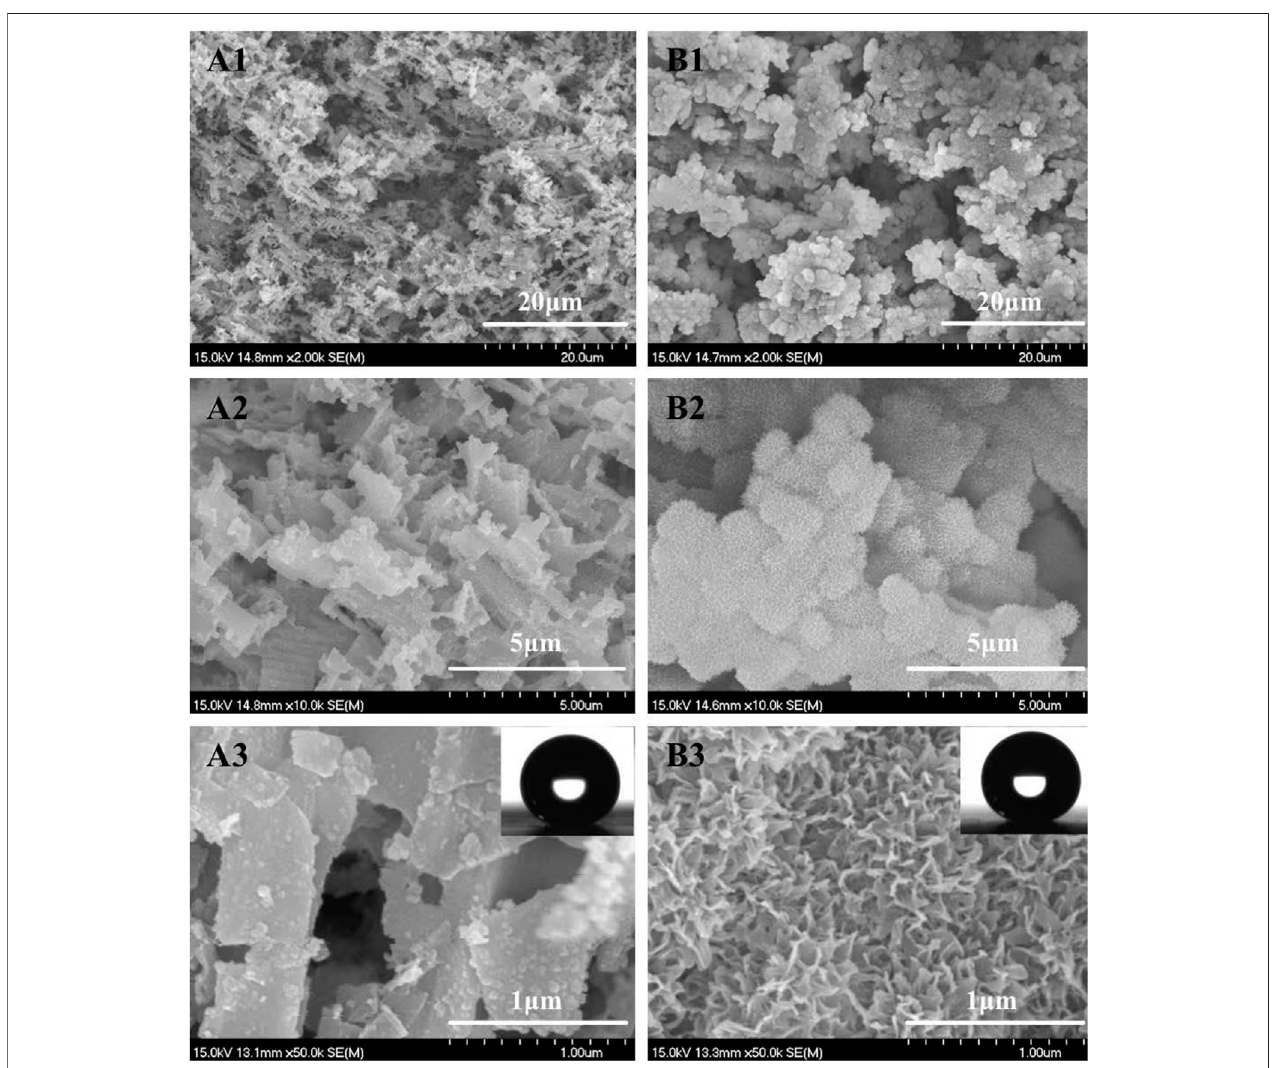
FIGURE 1 | FESEM images of the textured aluminum surface obtained by 12 min HCl etching (9 wt%) at 20 ° C (A) and further immersing in 50 ° C water for 40 min (B) . Magni fi cation from A1 to A3 or B1 to B3 is increased. The insets were pro fi les of 4 μ L water droplets showing WCA both at ~155 ° .